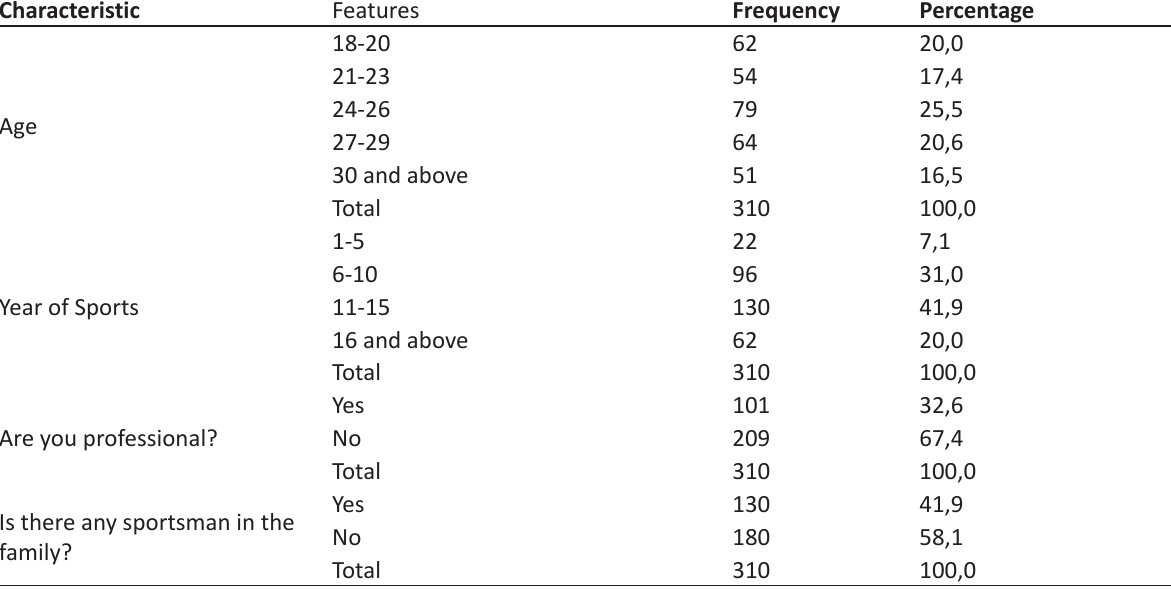
Table 1. Socio-demographical Features of Participants Characteristic